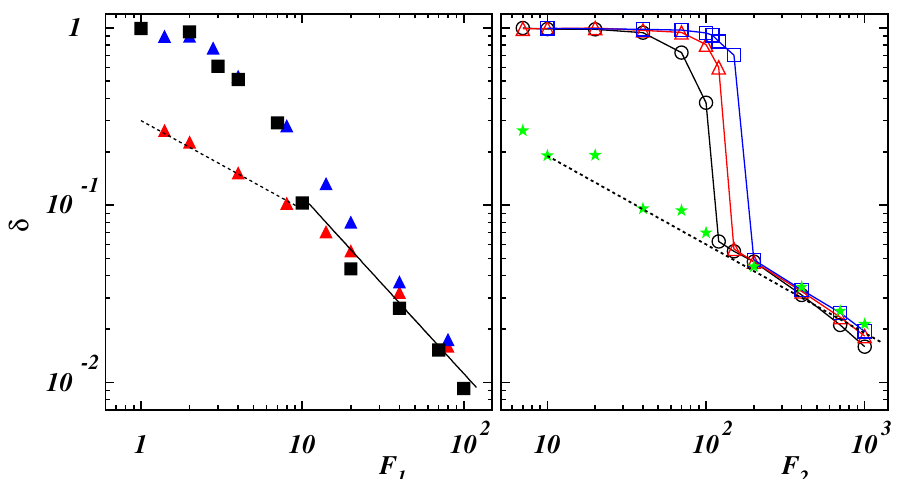
Figure 4. ( Left panel) Mean deficit length-ratio along the direction of the external force as a function of the dimensionless force F 1 = NFr 0 / ( k B T ) for L p / L = 0.1 (blue filled triangles), 0.2 (black filled squares) with (cid:101) / ( k B T ) = 2, and for L p / L = 0.1 (red filled triangles) with (cid:101) / ( k B T ) = 0.25. The dashed and full lines have slopes − 1/2 and − 1, respectively. ( Right panel) Mean deficit length-ratio along the direction of the external force as a function of the dimensionless force F 2 = NFL p / ( k B T ) for L p / L = 0.4 (black open circles), 0.6 (red open triangles), 0.8 (blue open squares), 2 (green filled stars) with (cid:101) / ( k B T ) = 2. The dashed line has slope − 1/2.